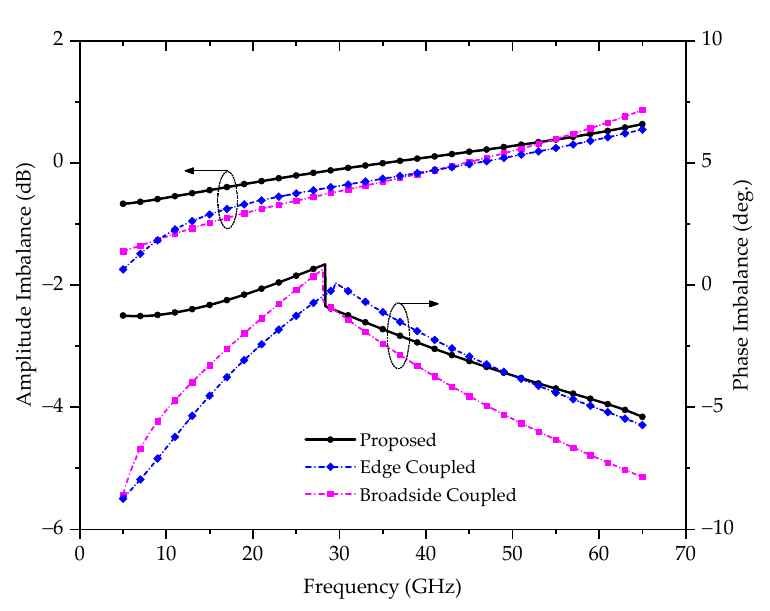
Figure 8. Plot of amplitude and phase balance.